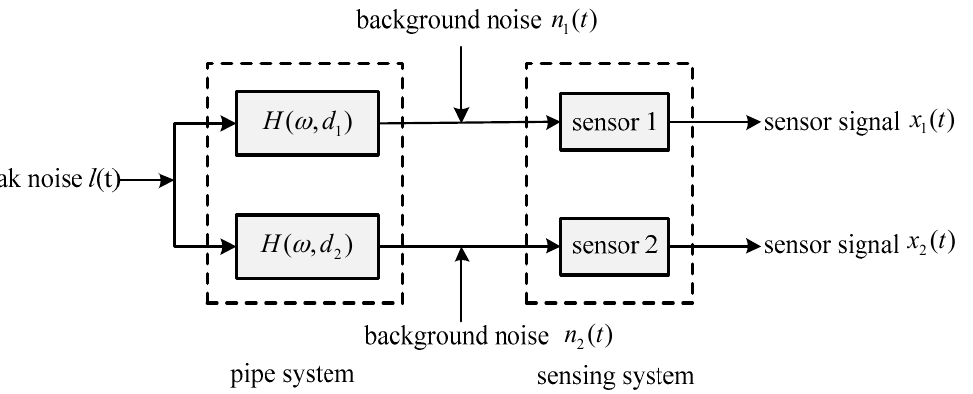
Figure 2. Flow diagram of leak noise measured by two sensors.